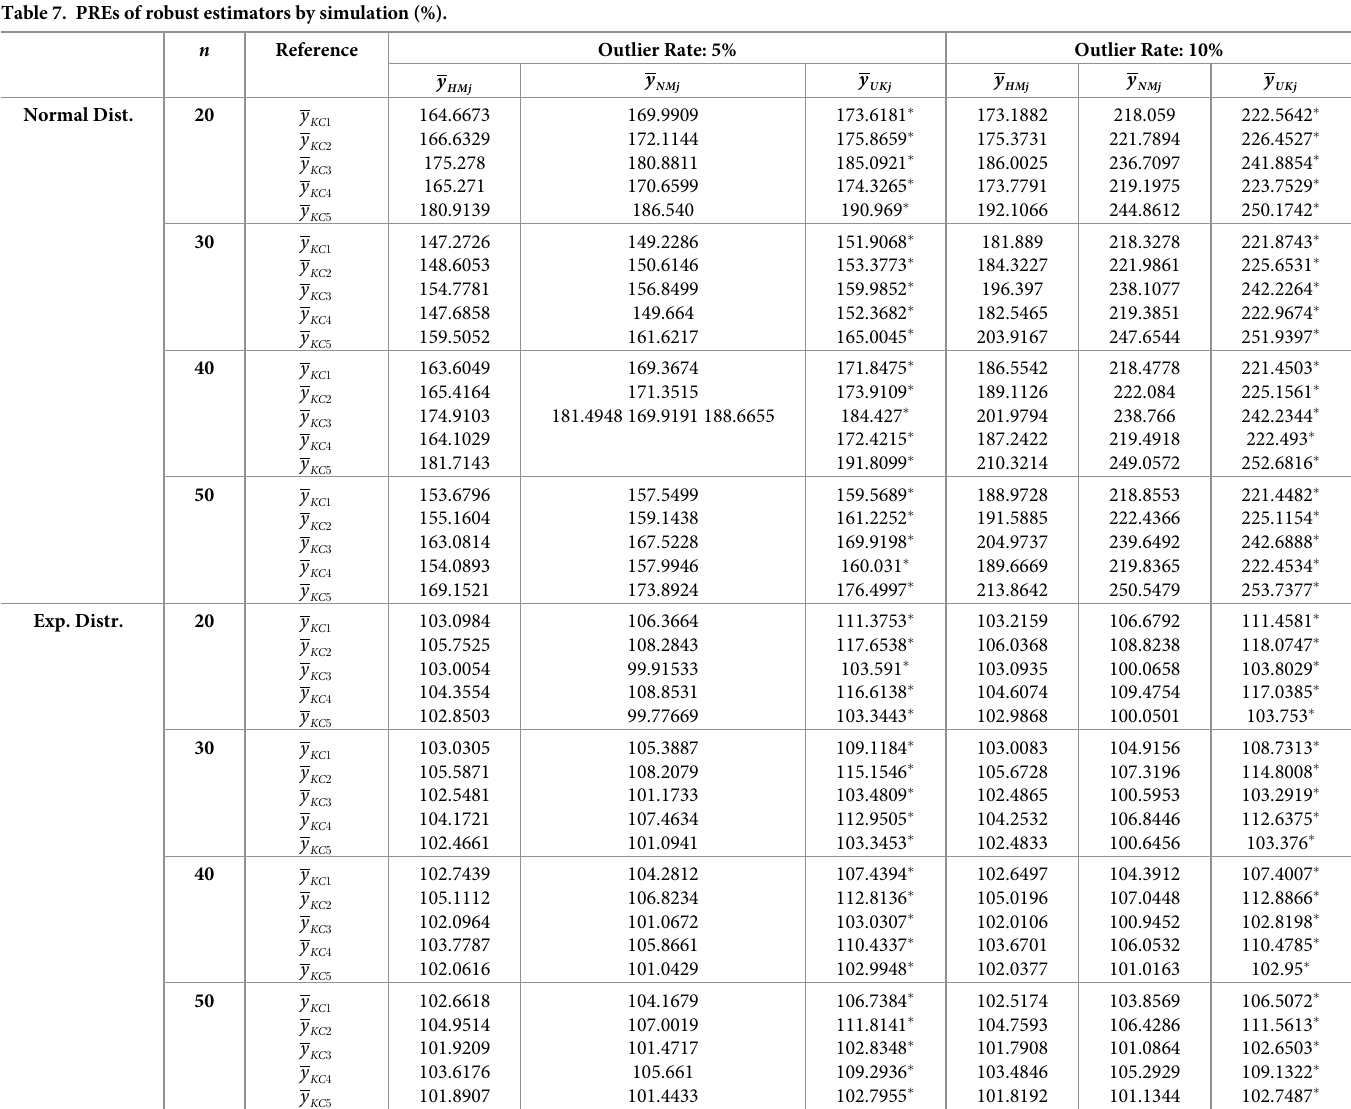
Table 7. PREs of robust estimators by simulation